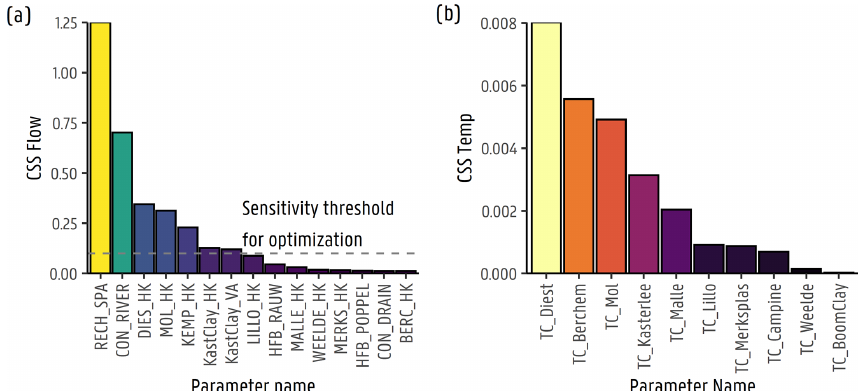
Figure A7. Composite scaled sensitivities for (a) groundwater flow parameters, where HK means horizontal hydraulic conductivity for the hydrogeological formations, VA is vertical anisotropy, HFB and CON represent the hydraulic conductance for the horizontal flow barriers and drains, and (b) heat transport parameters, where TC means thermal conductivity for each hydrogeological formation.